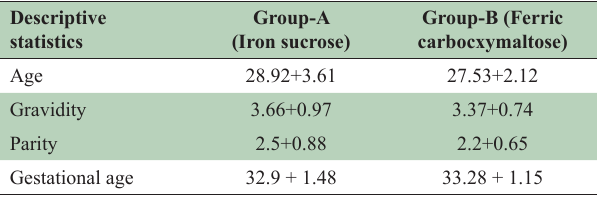
Table-I: Descriptive statistics distribution in both interventional groups.